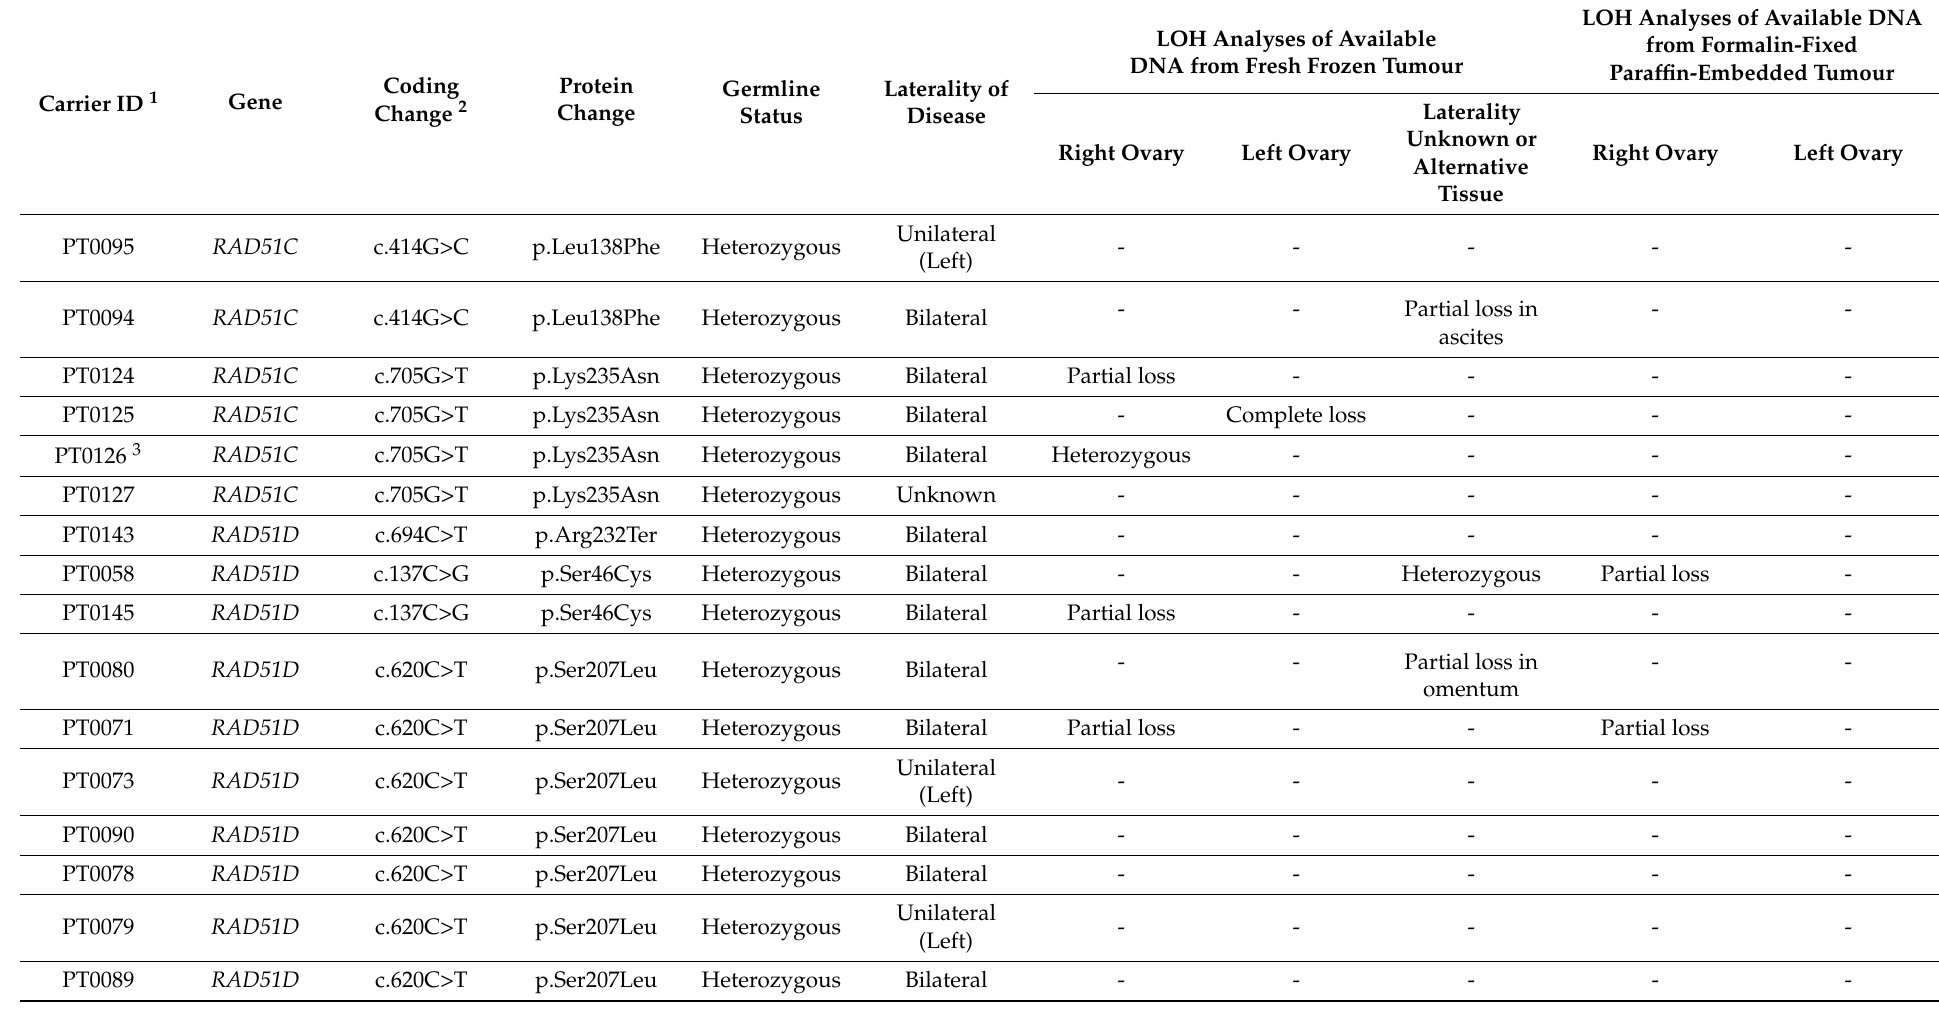
Table 3. Loss of heterozygosity (LOH) analyses of tumour DNA from ovarian cancer carriers by Sanger